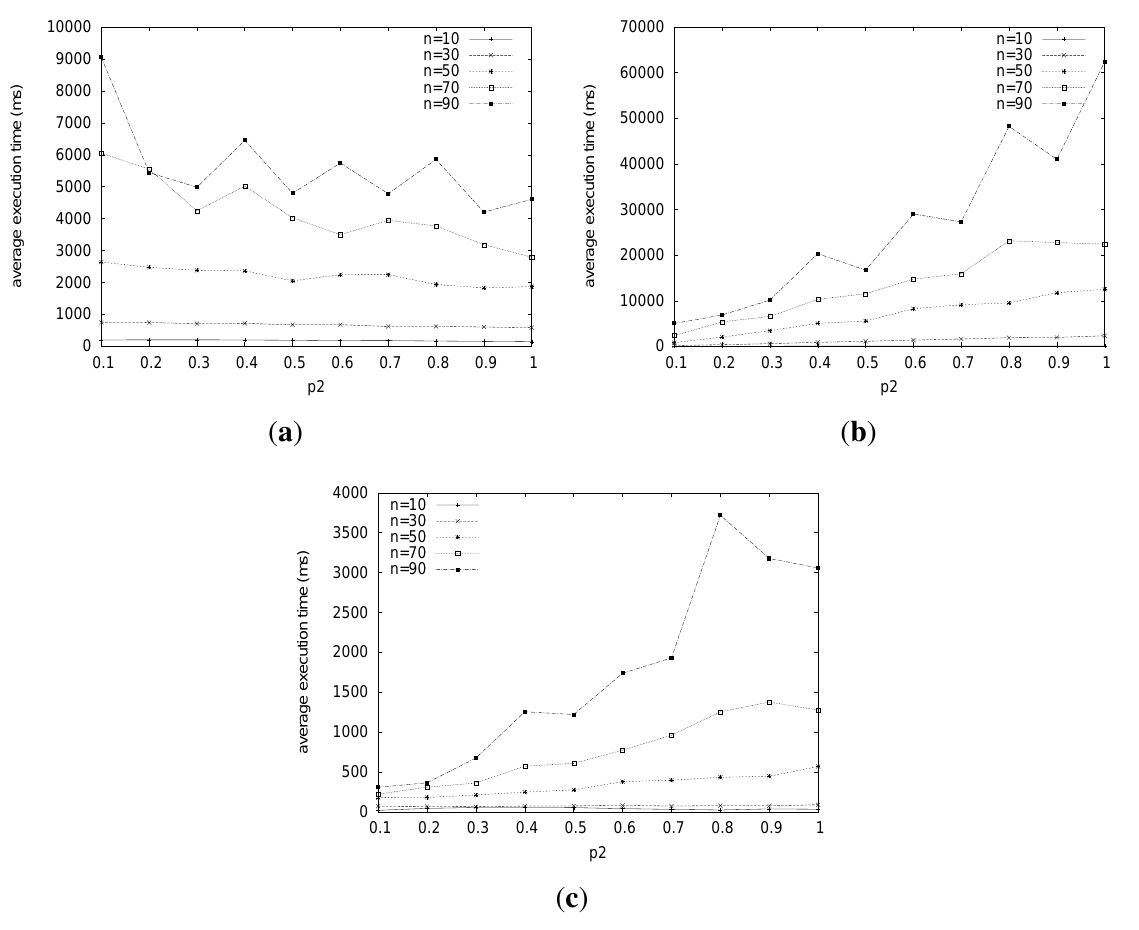
= 0.8 1 = 0.8 and t = 1